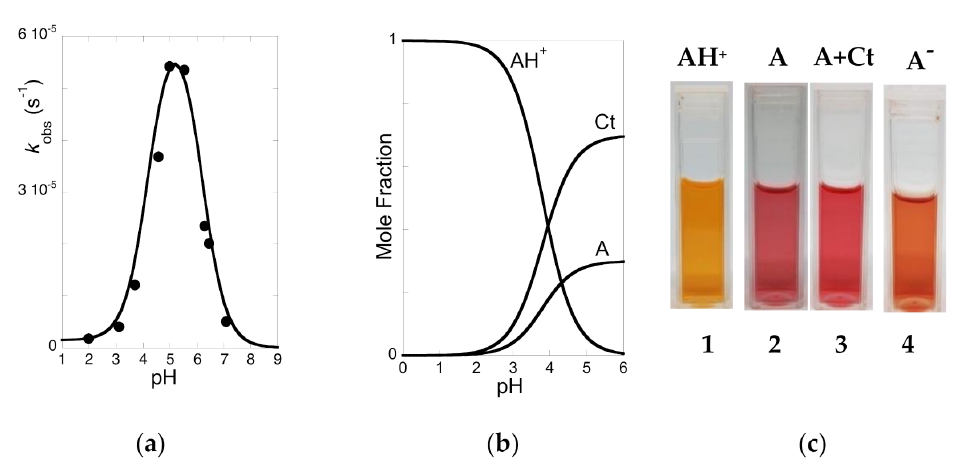
Figure 6. ( a ) Bell-shaped curve of the reaction towards equilibrium versus the pH of luteolin- idin at 2.5 × 10 − 5 M in ethanol:water (1:1). Fitting was performed using Equation (10) for ( b ) Mole fraction distribution of the species at equilibrium, which basically consists in a quinoidal base in equilibrium with trans -chalcone in CB ; and ( c ) ( 1 ) flavylium cation at pH = 1.0. ( 2 ) Quinoidal base immediately after a pH jump to pH = 5; ( 3 ) the same solution at the equilibrium; and ( 4 ) ionized quinoidal base immediately after a pH jump to pH = 8.0. Immediately after a direct pH jump to pH = 12, the color is dark orange (not shown). Adapted from